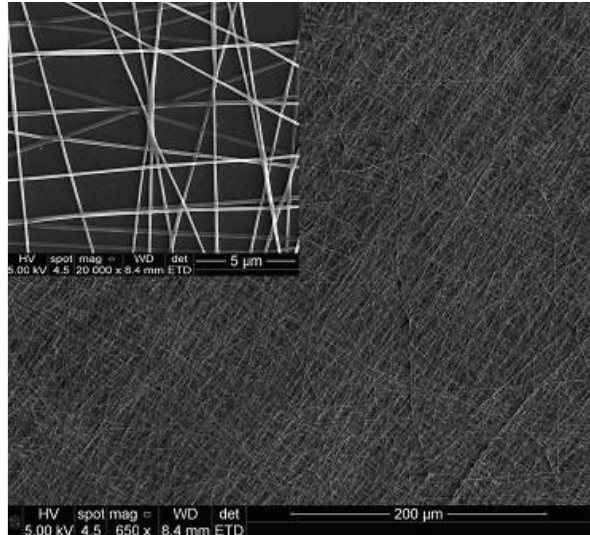
Figure 7. SEM image of the sensor layer made of polyvinyl alcohol (PVA) nanofibers on the SiO 2 guiding layer of Love wave SAW sensor [68]. Reprinted with permission from [68]. Copyright 2014 Elsevier.